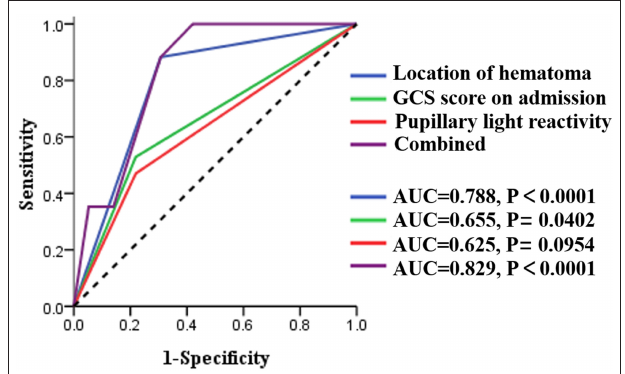
FIGURE 2 | ROC curve models of the three risk factors acquired from univariate analysis. AUC, area under the curve; CI, confidence interval; GCS, Glasgow Coma Scale.